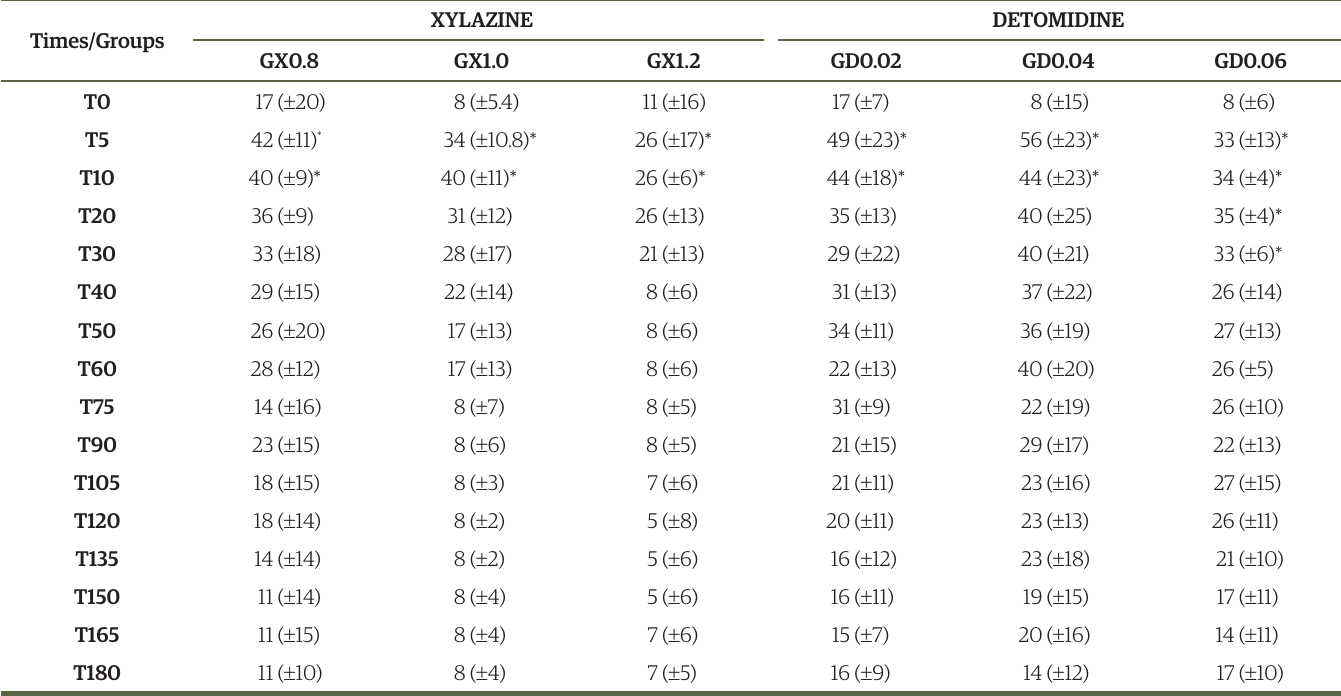
Table 4. Median ( ± Semi-interquartile range) electrostimulation (milliamperes) in donkeys from northeast Brazil sedated with detomidine or xylazine, given intravenously in different